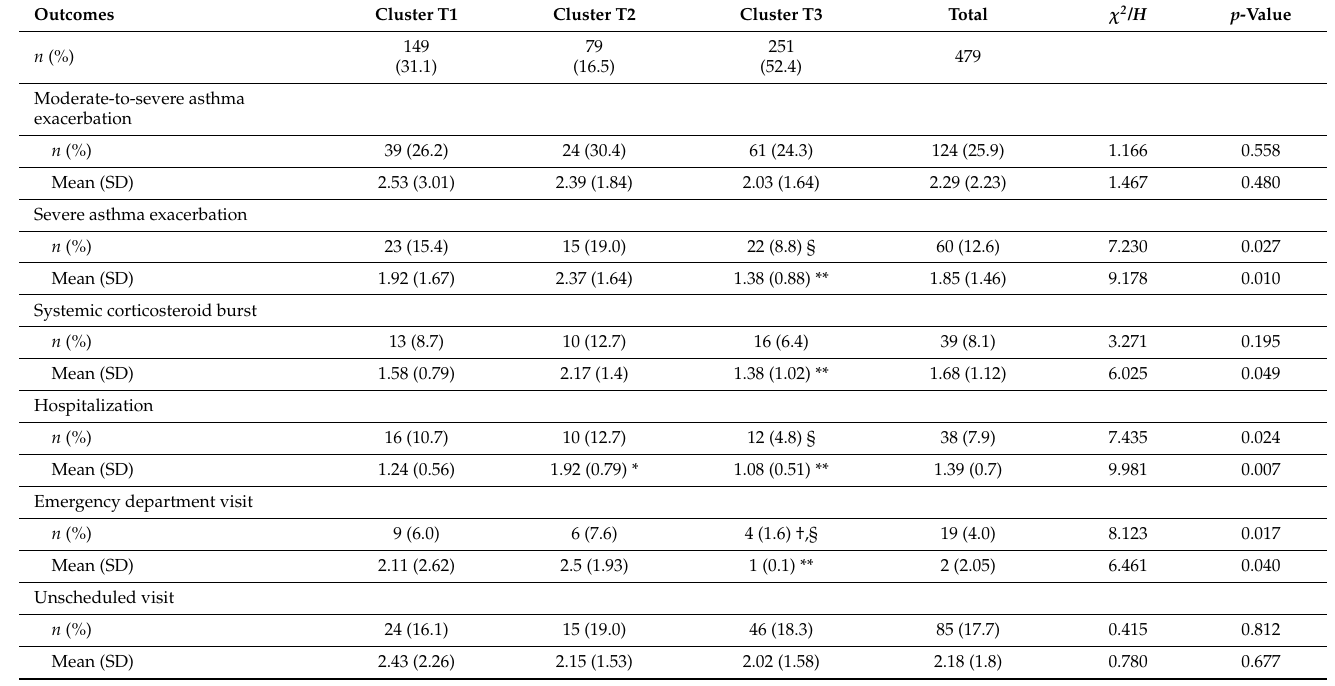
Table 3. Asthma exacerbation within the 12-month follow-up period in the training